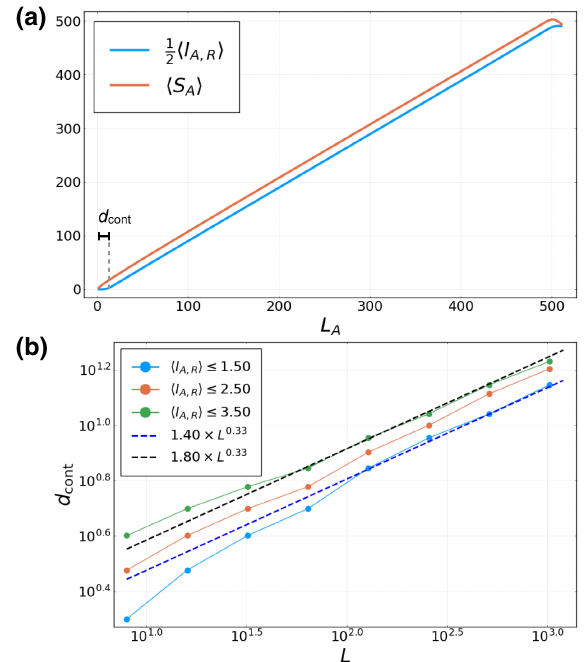
FIG. 8. (a) The mean DPRE entanglement entropy (cid:6) S A (cid:7) and the mean DPRE mutual information (cid:6) I A , R (cid:7) . The nonmonotinic- ity in (cid:6) S A (cid:7) at L A (cid:2) L and the vanishing of (cid:6) I A , R (cid:7) at small L A are signatures of the error-correcting properties of the weakly moni- tored phase [10]. (b) The contiguous code distance d cont extracted from (a), namely the value of L A when (cid:6) I A , R (cid:7) = (cid:13) , for a few differ- ent values of (cid:13) . We find that d cont ∝ L β , a result consistent with Clifford numerics in Ref. [